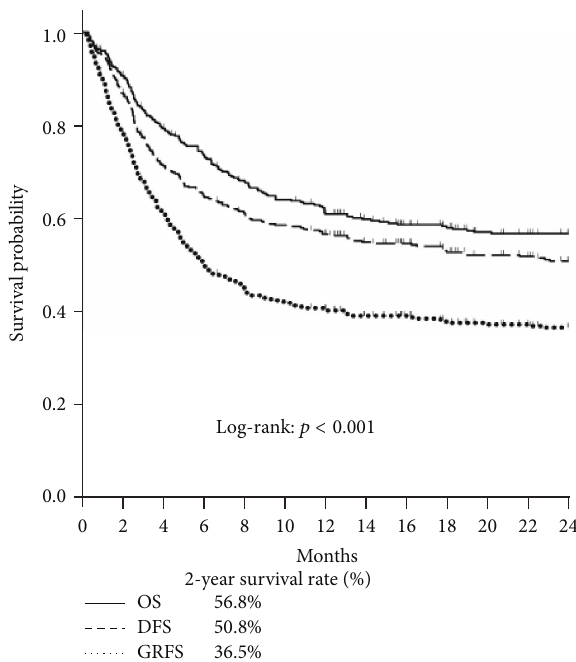
Figure 2: Kaplan-Meier estimates of 2-year GRFS.